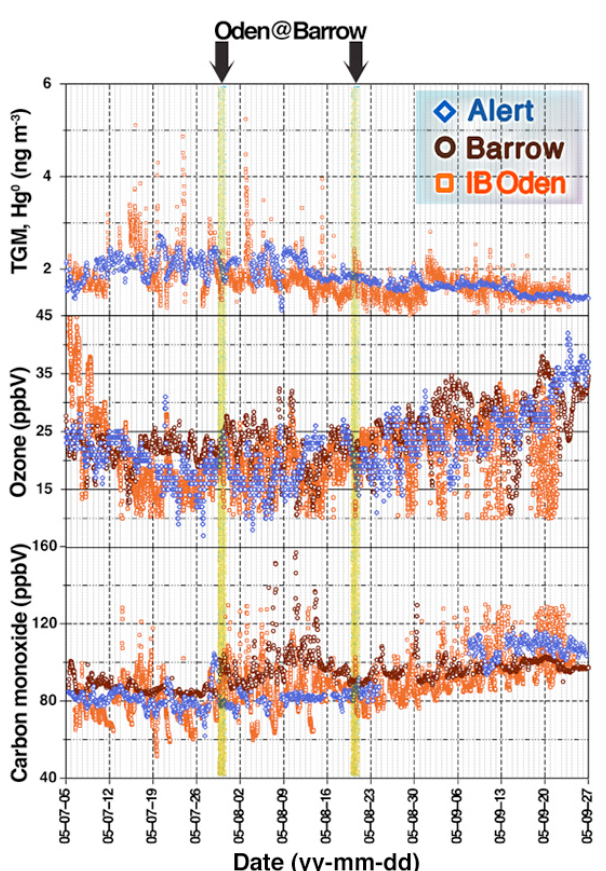
Fig. 6. Comparison of Oden (orange squares), Barrow (brown cir- cles) and Alert (blue diamonds) observations for TGM, Hg 0 (upper panel), O 3 (middle panel) and for CO (lower panel). The time se- ries from IB Oden depicted are comprised of 10-min averaged data while the others refer to hourly averaged data. Periods shaded in yellow resemble anchorage time of IB Oden outside Pt. Barrow.